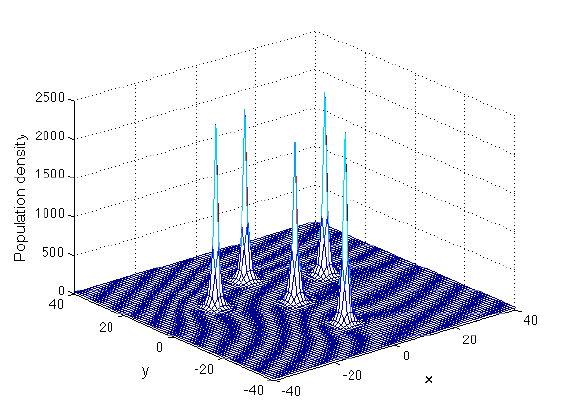
Fig. 3. Insect distribution after 15 time units using setting (D).